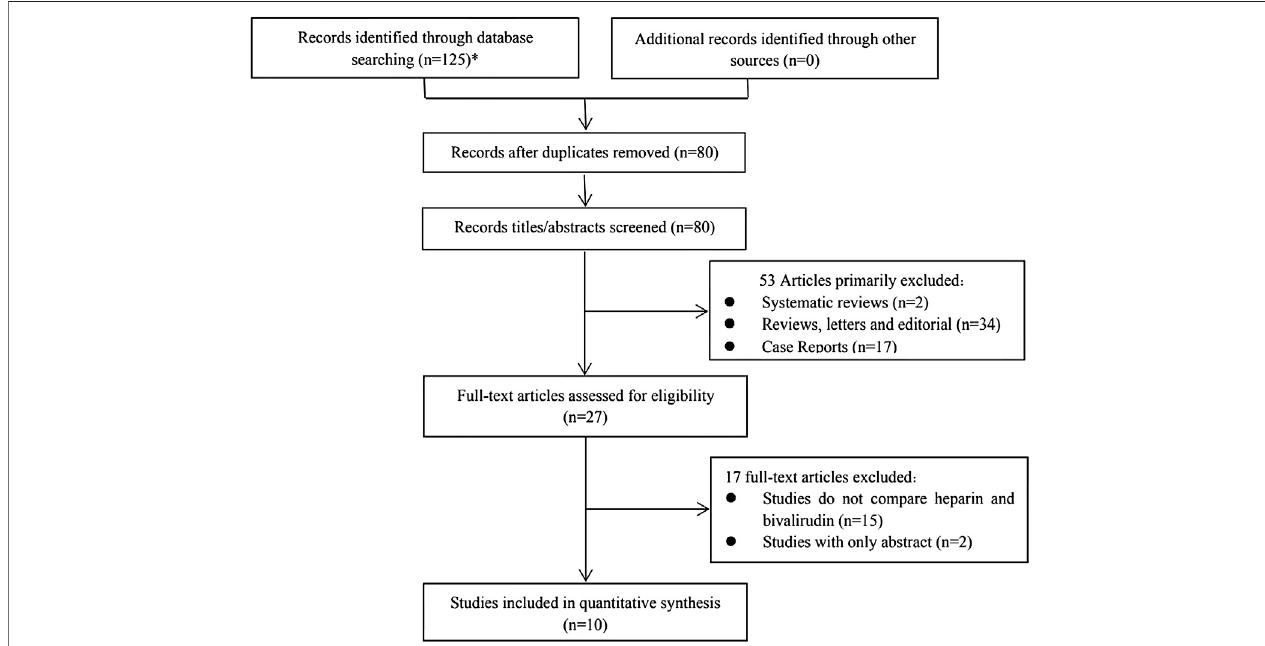
FIGURE 1 | Flow chat of study selection (*101 from Embase, 20 from Pubmed and 4 from The Cochrane Library).